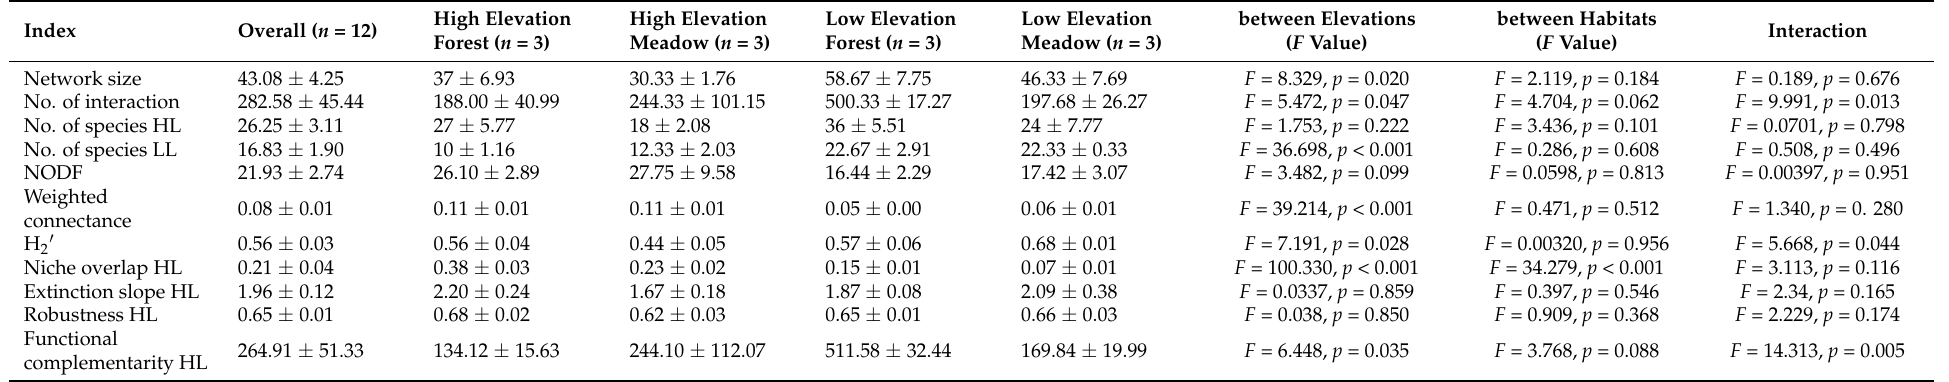
Table 3. Network-level properties of beetle-plant networks ( n = 12) from two elevations and two habitats. HL (high level of network) refers to beetles while LL (low level of network) refers to